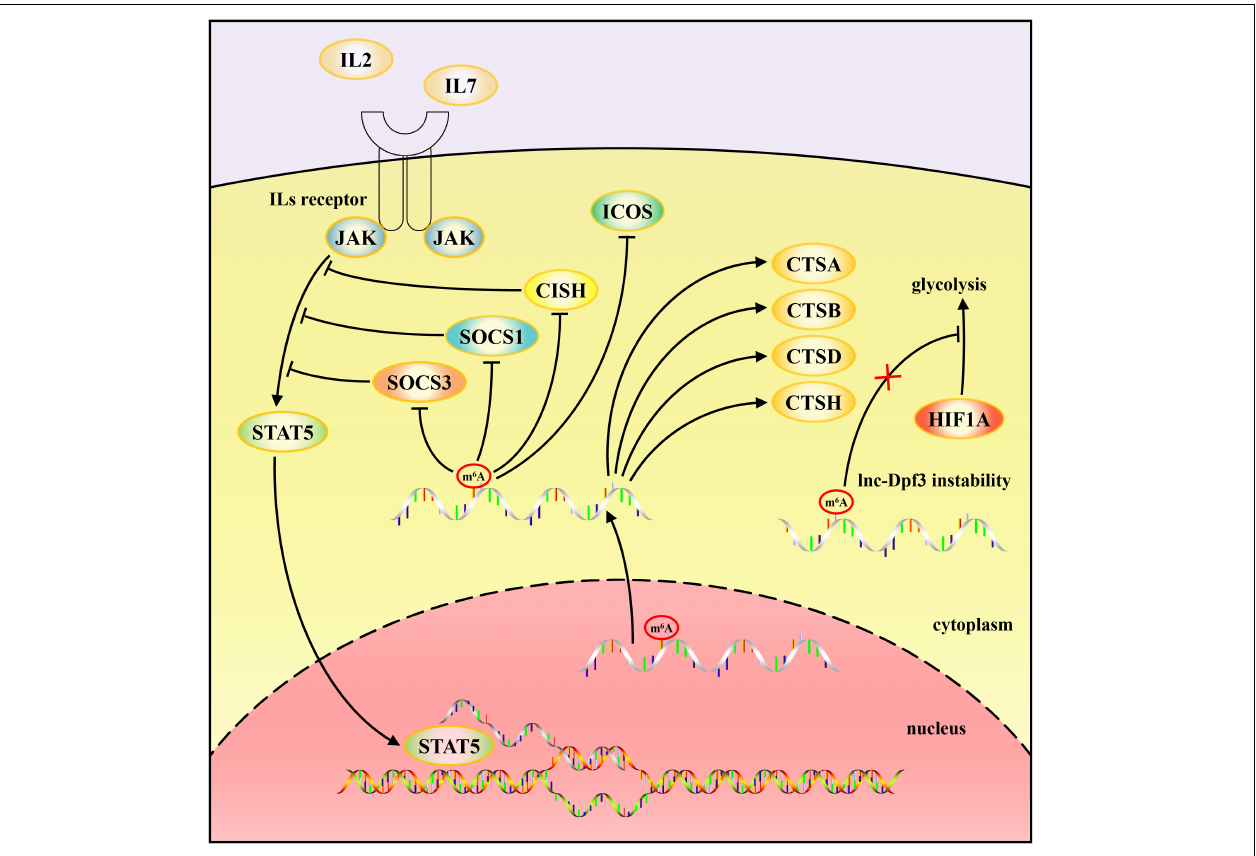
FIGURE 2 | Schematic diagram of mechanisms by which m 6 A modification regulates adaptive immune responses. m 6 A modification of SOCS1 , SOCS3 , CISH mRNA, and lnc-Dpf3 accelerate their decay. Translation of lysosomal cathepsins, including CTSA, CTSB, CTSD, and CTSH, are promoted by m 6 A and YTHDF1, whereas the expression of ICOS is inhibited by m 6 A